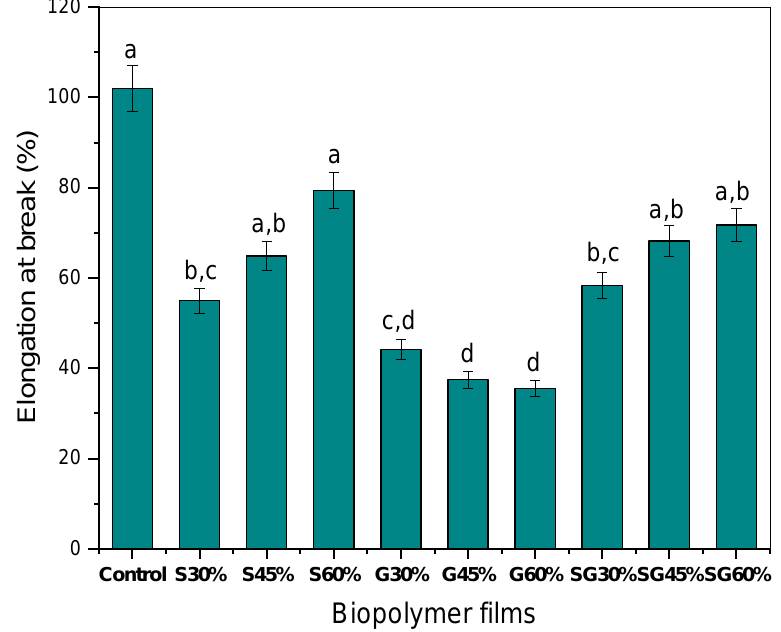
Figure 6. Elongation at break of cornstarch-based film with different plasticizers. a,b,c Values with different letters in the figures are significantly different ( p < 0.05).